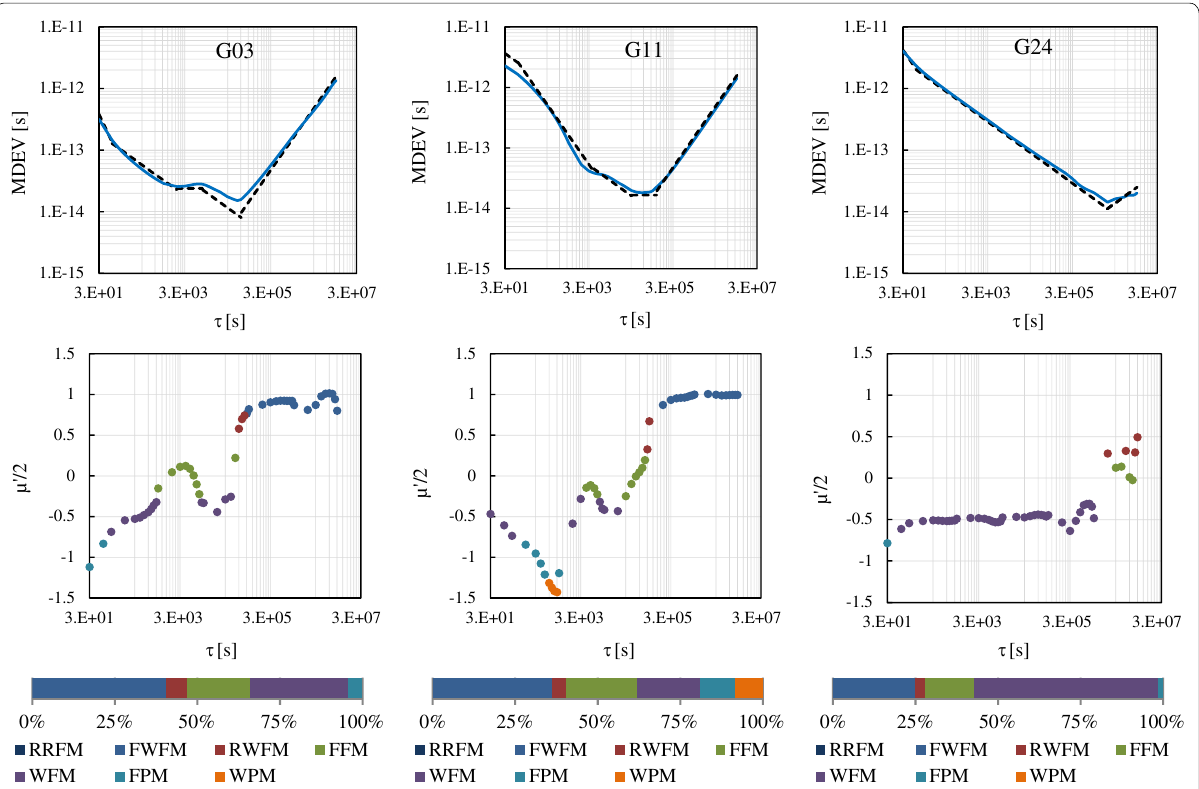
Fig. 4 The noise processes in MDEV variance plot with fitted noises slopes (top), proposed method (middle) and percentage distribution of noise types of the analysed data based on the proposed method (bottom)